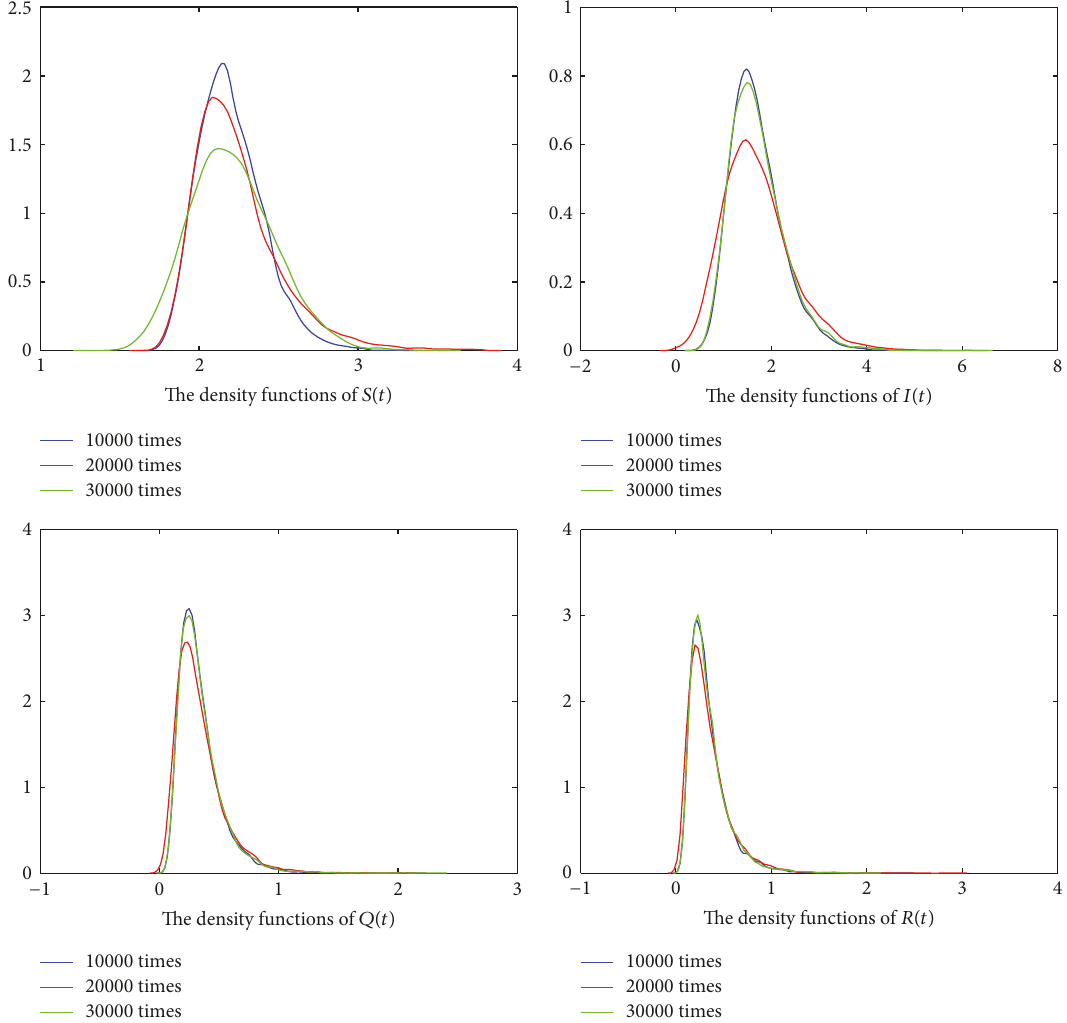
Figure 2: Based on the 10000 sample paths, after iterating 10,000 times, 20,000 times and 30,000 times, respectively, we get the density functions of 𝑆(𝑡), 𝐼(𝑡), 𝑅(𝑡) and 𝑄(𝑡) with 𝑆(0) = 0.3, 𝐼(0) = 0.3, 𝑄(0) = 0.2 , and 𝑅(0) = 0.2. Here Δ𝑡 = 0.01